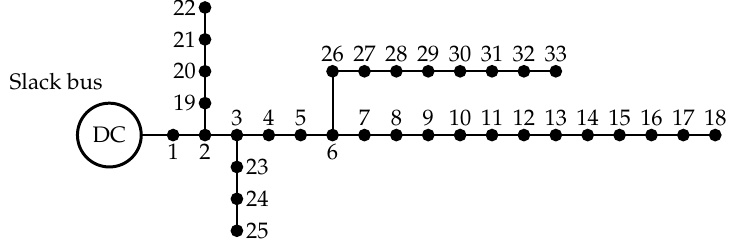
Figure 4. Electrical configuration for the 33-bus test